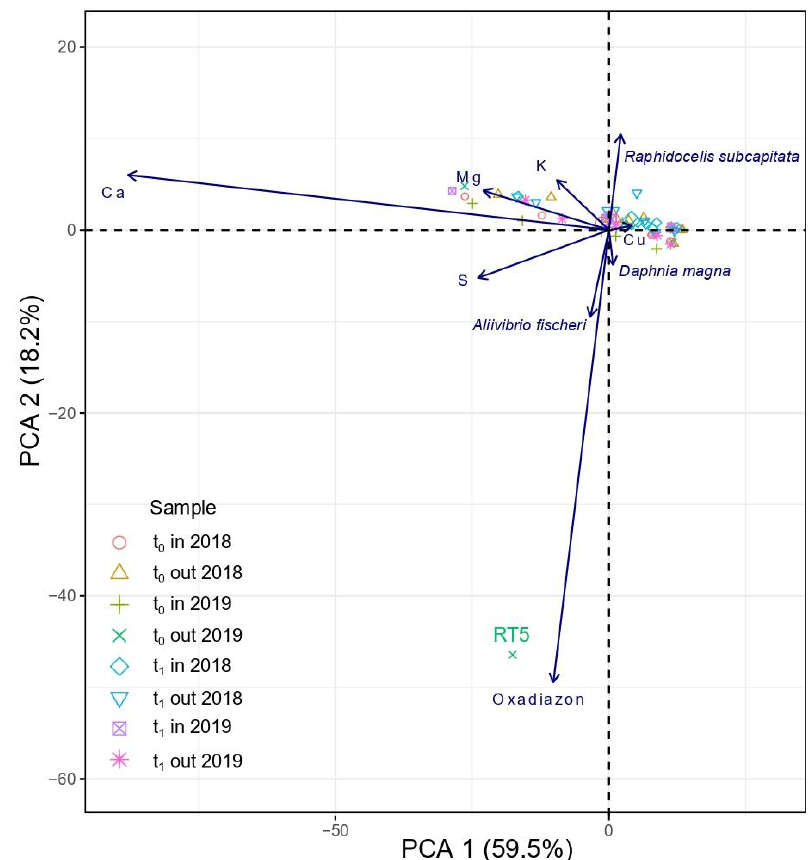
Figure 2. Plot of PCA applied to chemical and ecotoxicological characteristics of all water samples from rice paddies (t 0 and t 1 labels refer to the campaigns before and after PPPs treatment, respectively; in and out indicate the samples taken from streams entering and exiting the paddy water chamber, respectively, in 2018 and 2019. Only parameters (blue arrows) that contribute more than 15% in the variability of the samples are shown.